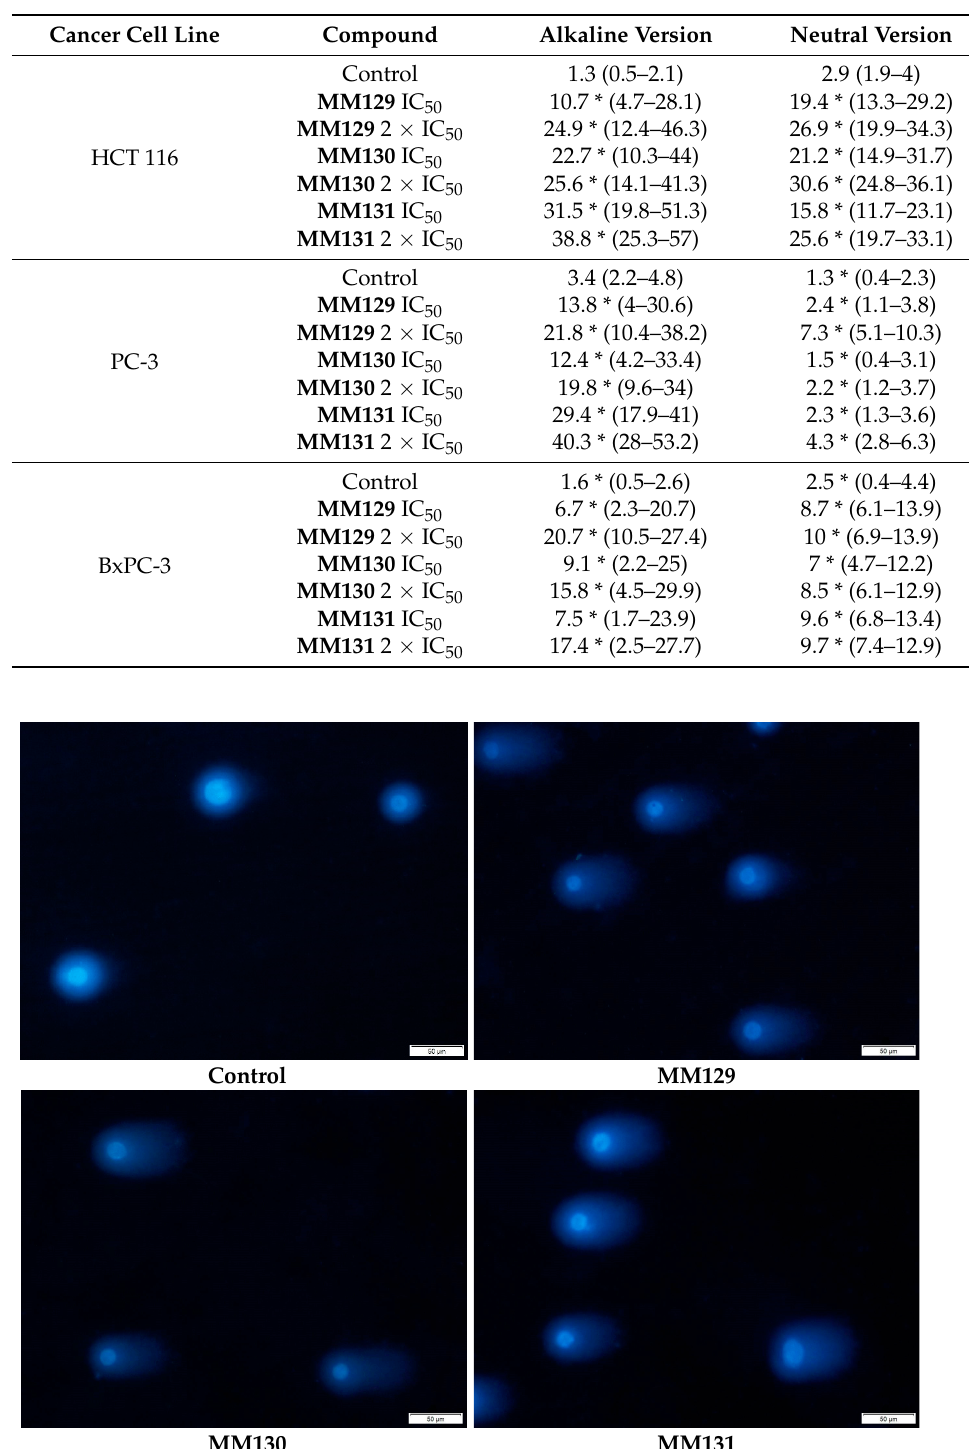
Figure 4. Representative images of comets acquired in the neutral version of the comet assay after incubation of HCT 116 cells with MM129 , MM130 , and MM131 in the concentrations equal to their 2 × IC 50 values. The scale bar is 50 μ m.